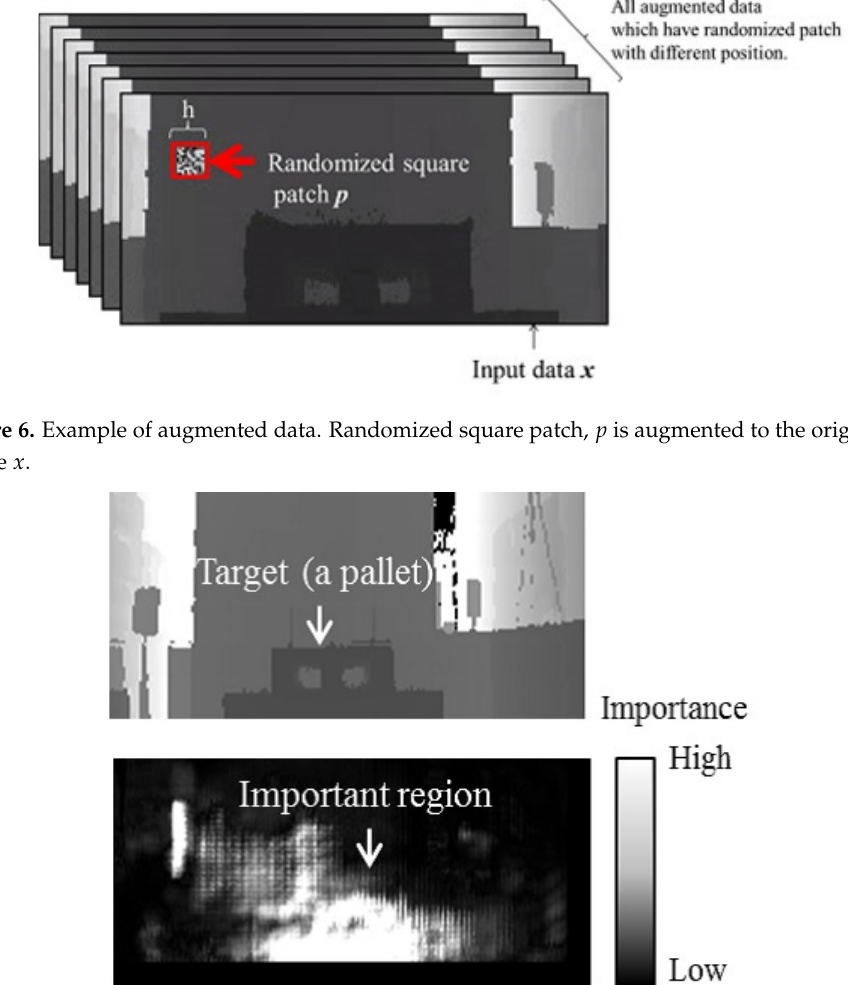
Figure 7. Examples of raw input ( top ) and importance image ( bottom ). In this example, pixels around a pallet that the AGV approaches are important for convolutional neural network (CNN)-based